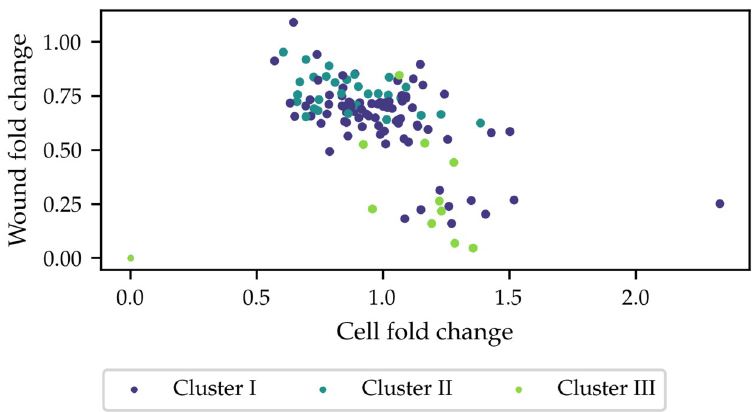
Fig 9. Observed wound area fold change as a function of cell fold change. Across the range of cell fold changes, starkly different rates of wound closure are observed.